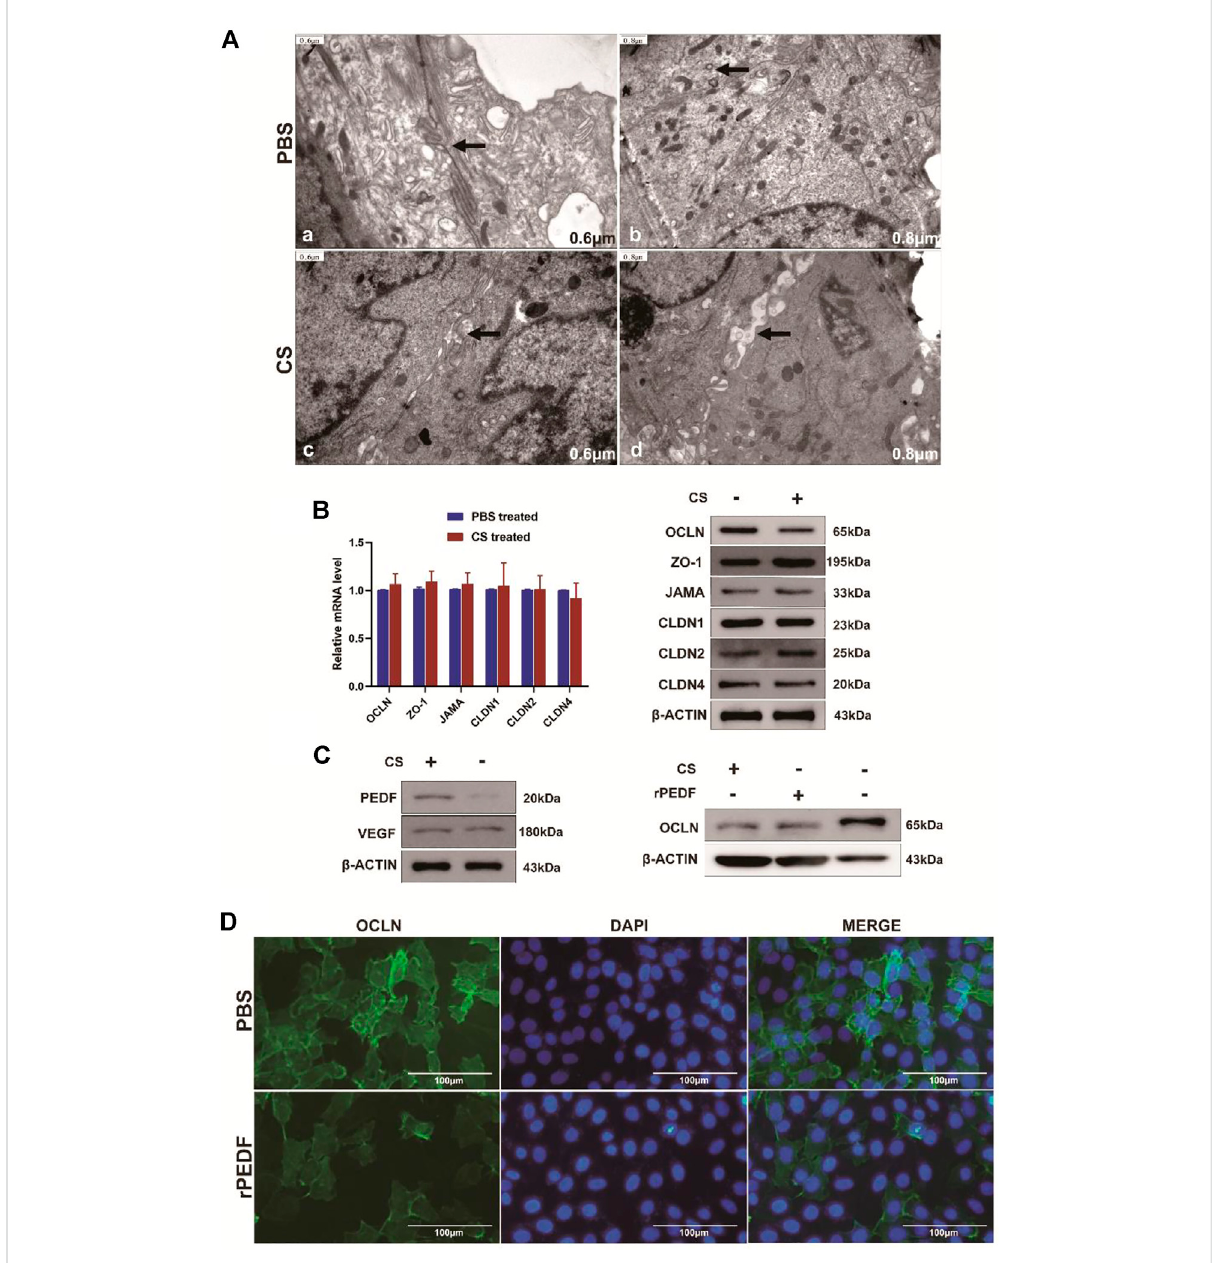
related genes at transcription and translation levels after CS treatment. (C) After CS treatment, the PEDF expression increased, while the VEGF expressiondidnotchangesigni fi cantly.AfterCSorrPEDFtreatment,theOCLNexpressionwassigni fi cantlyreduced. (D) Fluorescenceintensity of OCLN decreased obviously after being treated with